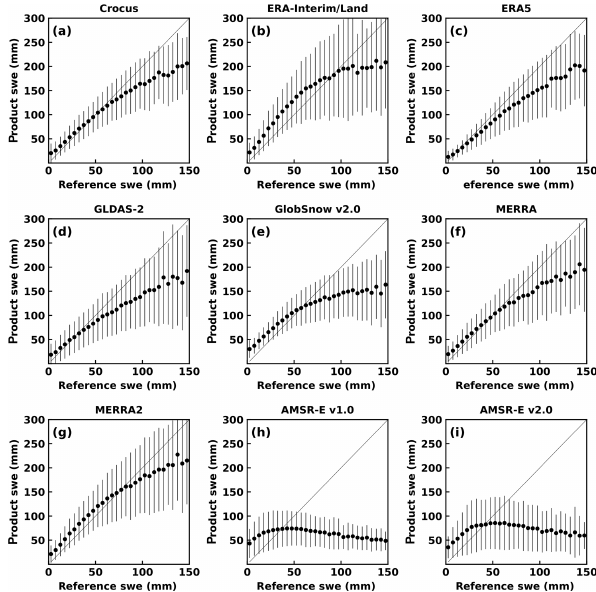
Figure 4. Performance of SWE datasets versus reference snow course SWE ± 1 standard deviation for (a) Crocus, (b) ERA- Interim/Land, (c) ERA5, (d) GLDAS-2, (e) GlobSnow v2.0, (f) MERRA, (g) MERRA-2, (h) AMSR-E v1.0, and (i) AMSR-E v2.0. SWE values above 300mm are not